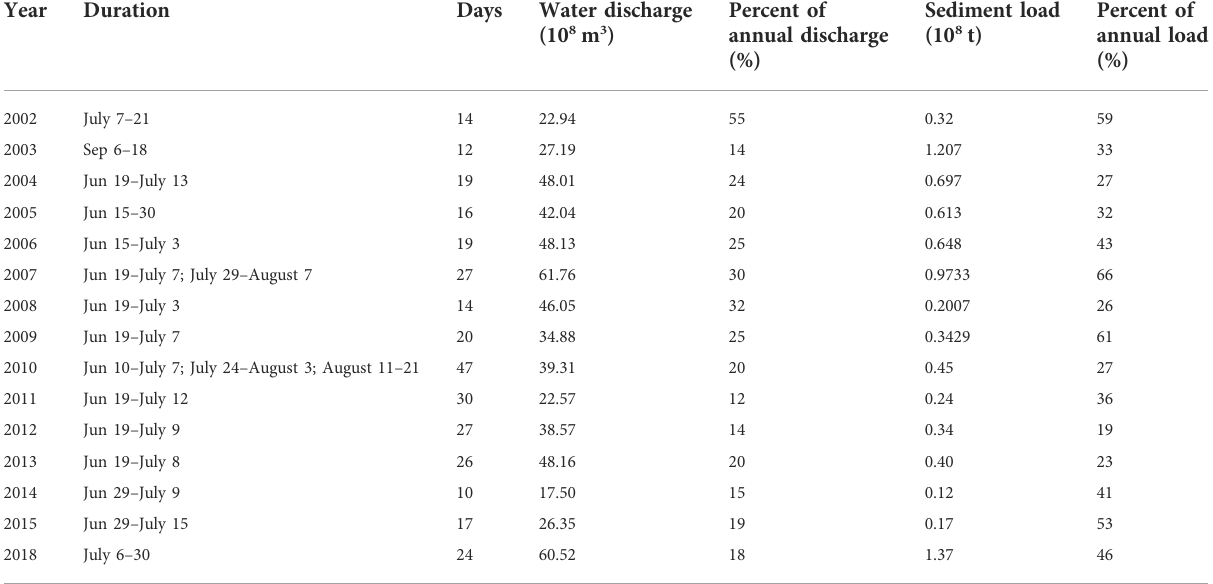
TABLE 1 Historical hydrological data during the